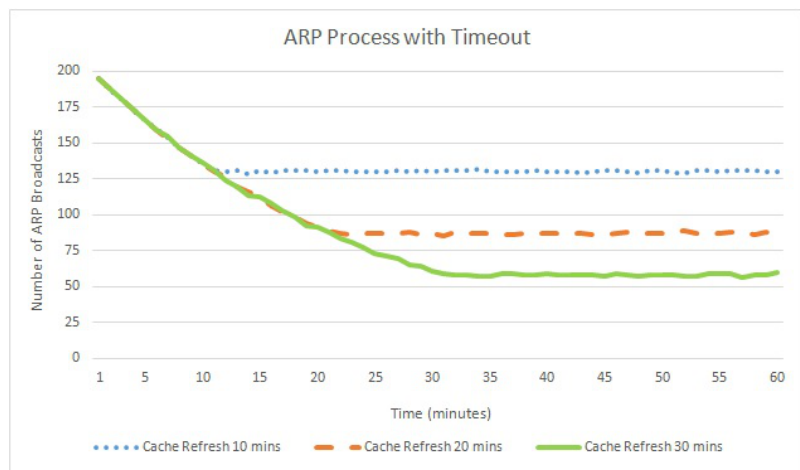
Figure 8. ARP process with time-out = 10, 20 and 30 min (Type 2).